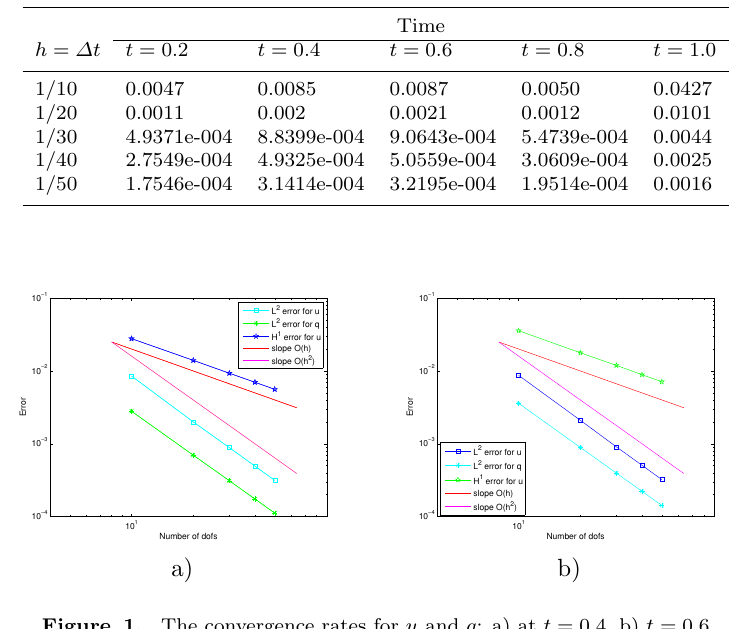
(cid:107) at different time. h